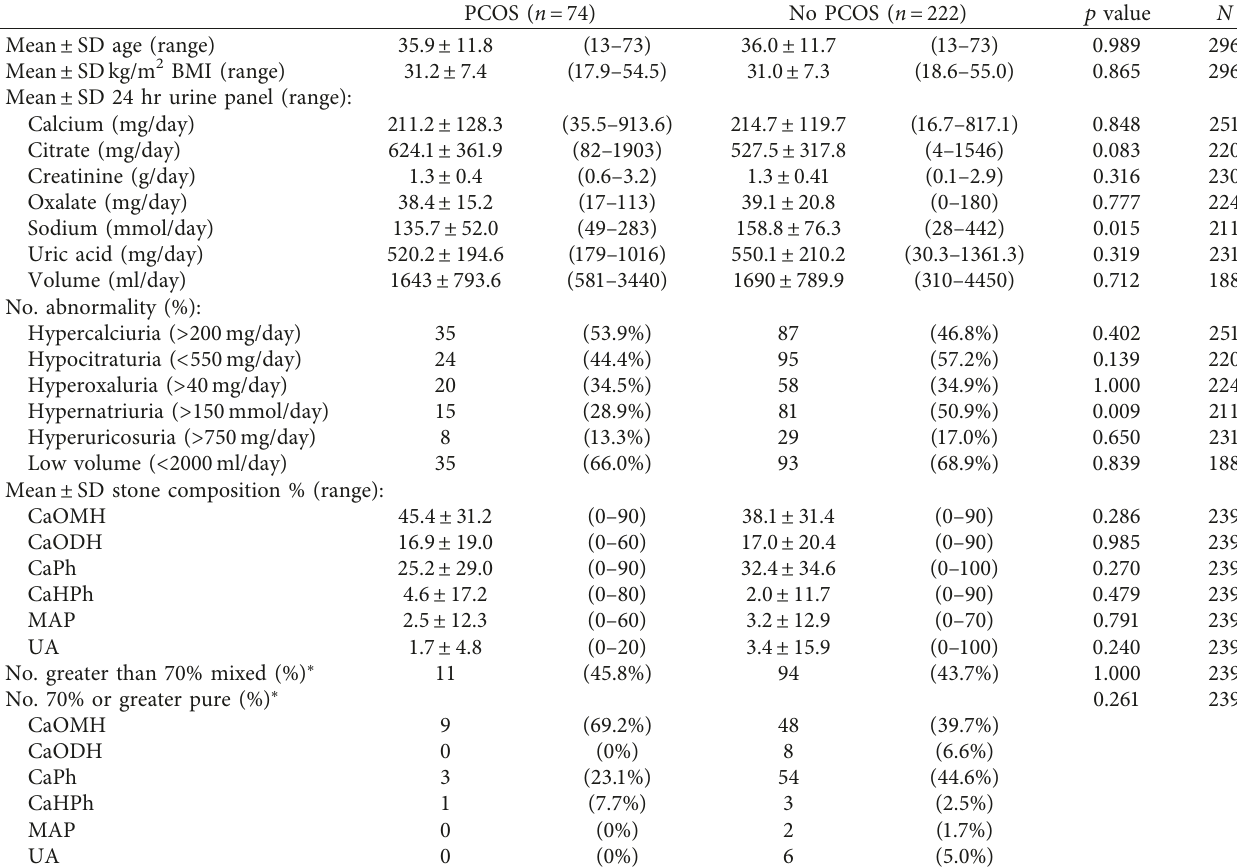
Table 1: Bivariate analysis using PCOS status within case-control